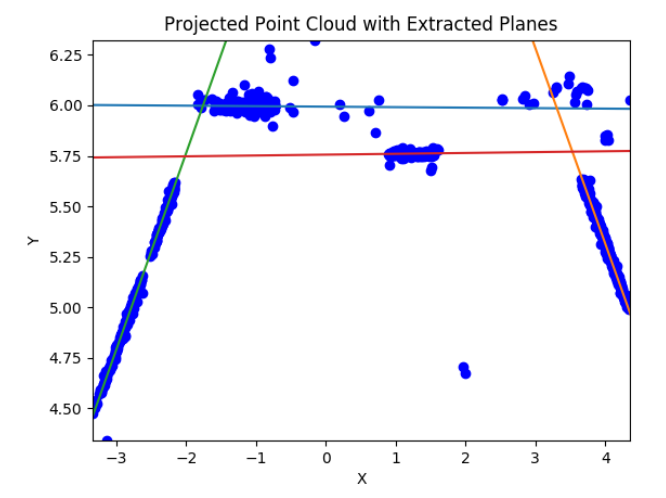
Figure 4. Extracted planes from the point cloud.